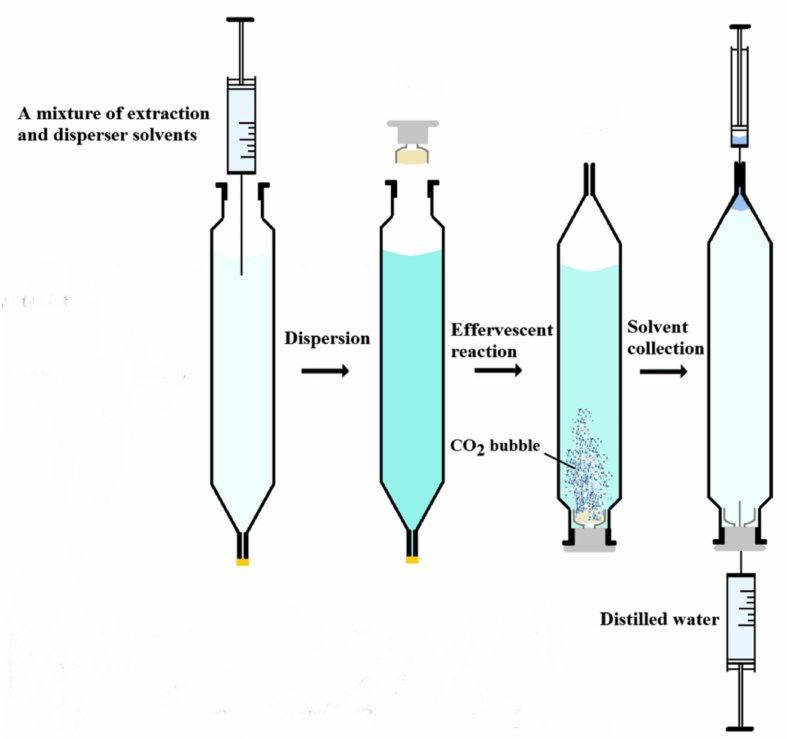
Figure 6. Use of e ff ervescence tablets for phase’s separation in DLLME. Adapted with permission of Springer from reference